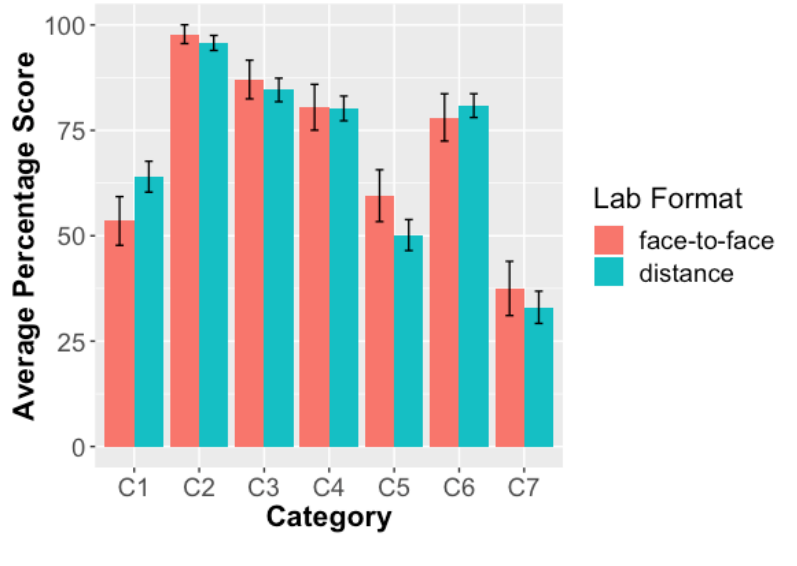
Figure 2 . Average percentage scores in the seven categories of the project grading rubric (see Table 3). The error bars show 95% confidence intervals.